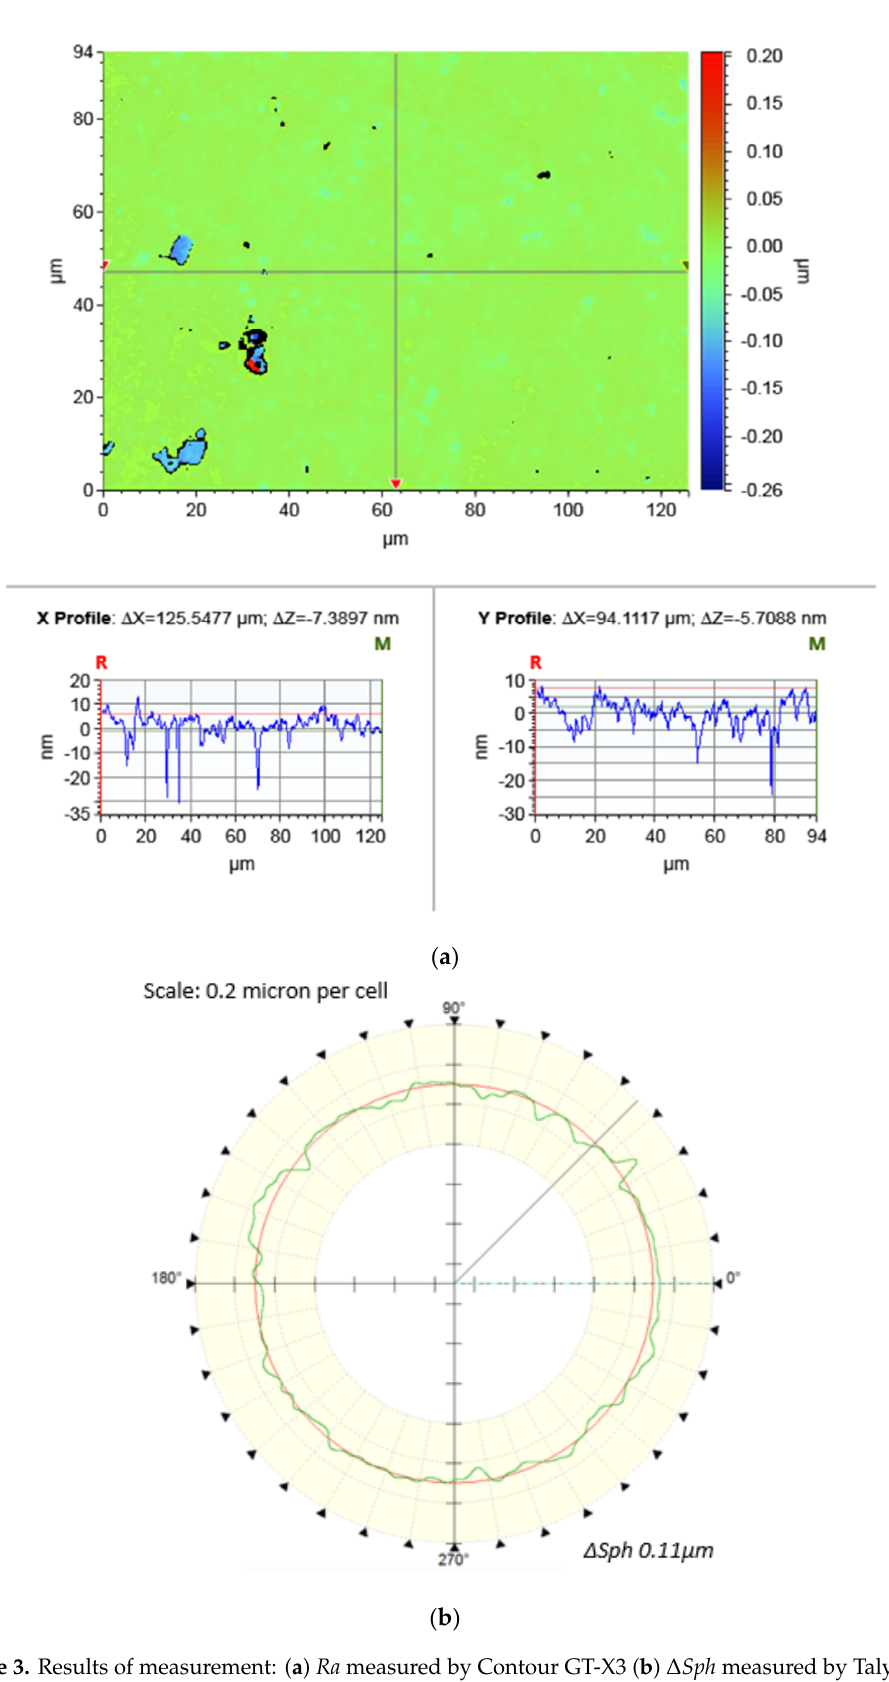
Figure 3. Results of measurement: ( a ) Ra measured by Contour GT-X3 ( b ) ∆ Sph measured by Talyrond 585 LT.